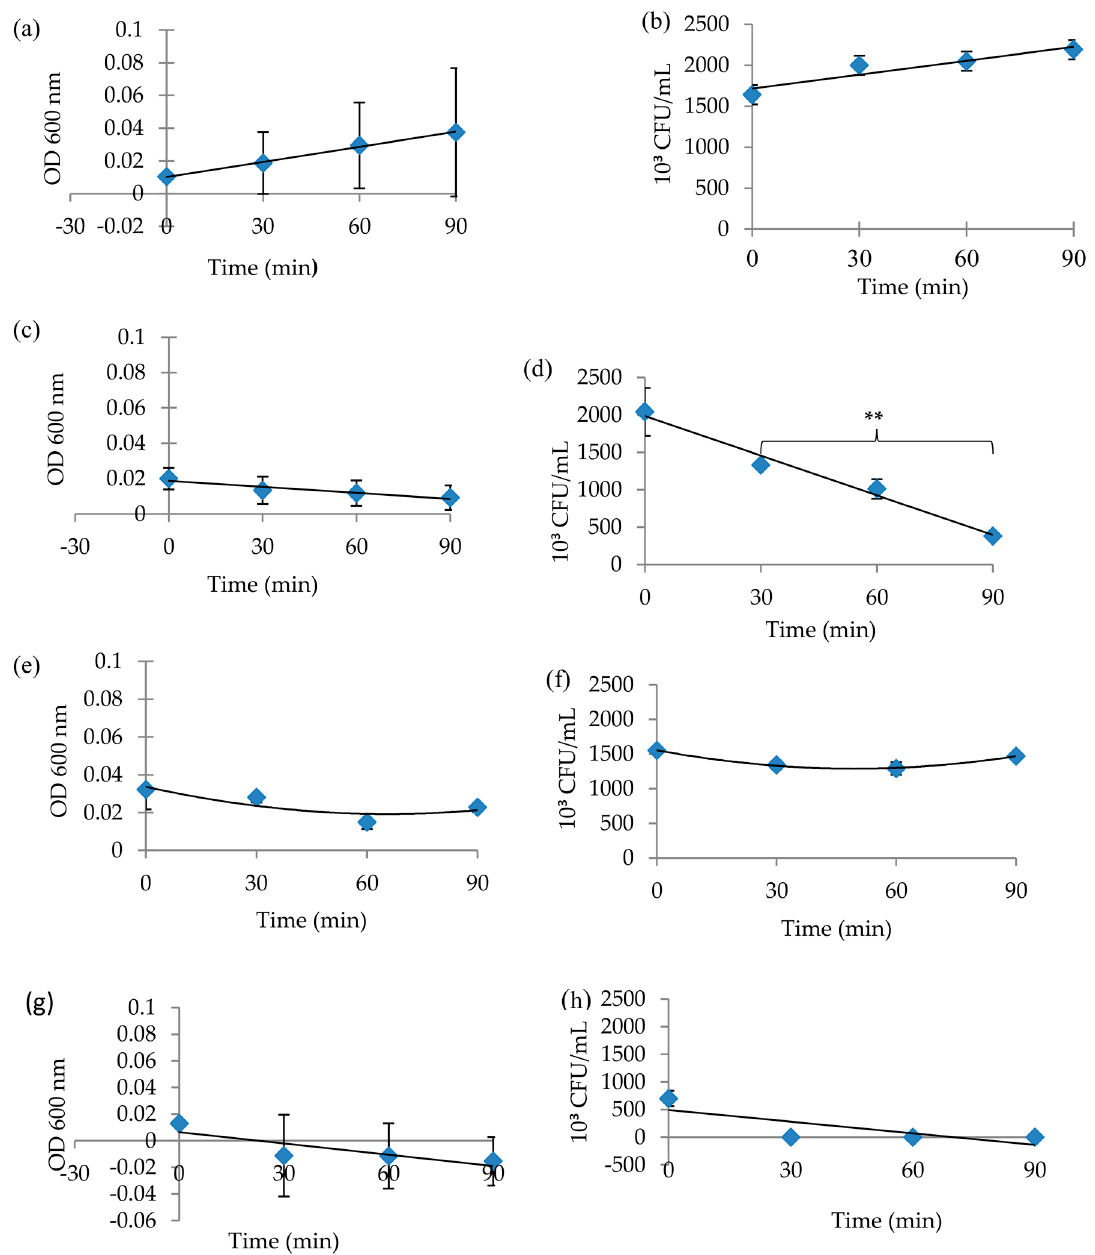
Figure 2. Growth curve of methicillin resistant Staphylococcus aureus ( MRSA ) for the susceptibility test after exposure to 0.4 g/mL of extract from 0 to 90 min. ( a ) control OD values, ( b ) control viable count values, ( c ) cinnamon aqueous extract OD values, ( d ) cinnamon aqueous extract viable count values, ( e ) kaffir lime aqueous extract OD values, ( f ) kaffir lime aqueous extract viable count values, ( g ) lime juice OD values, and ( h ) lime juice viable count values. The Dunnett T3 test indicated that the viable count values for the cinnamon aqueous extract at 30 min and 90 min differed significantly from each other (** p < 0.01). Results were expressed in OD (600 nm) and 10³ CFU/mL, respectively, with n = 2.